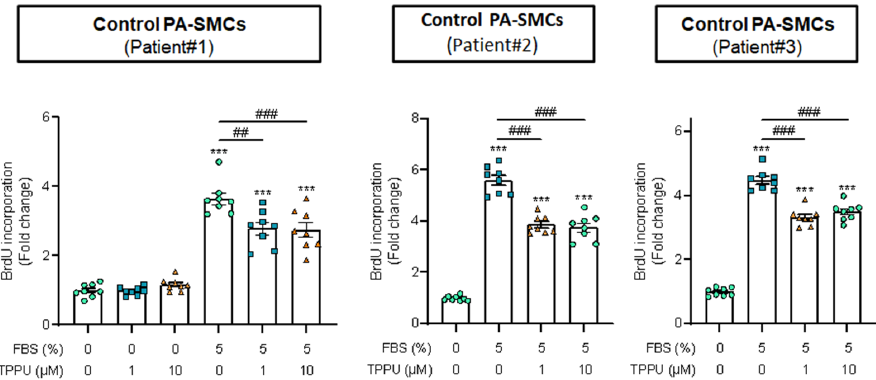
Figure 6. Impact of the soluble epoxide hydrolase inhibitor TPPU on the proliferation of human pulmonary artery smooth muscle cell (PASMC) assessed using 5-bromo-2-deoxyuridine (BrdU) incorporation. Technical replicates with PASMCs derived from three different patients. *** p < 0.001 vs. 0% FBS; ## p < 0.01 and ### p < 0.001 vs. 5% FBS without TPPU.